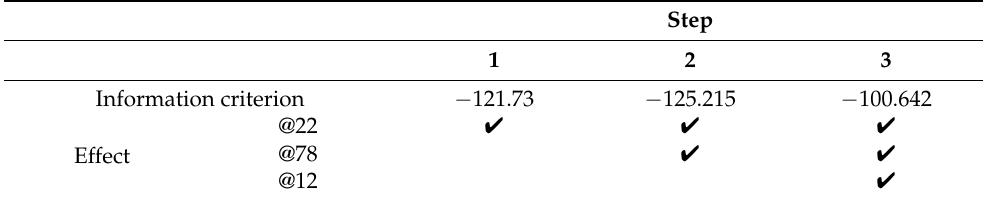
Figure 9. The model of the factors influencing the electricity consumption of urban households. Table 3. The variables draw into the final